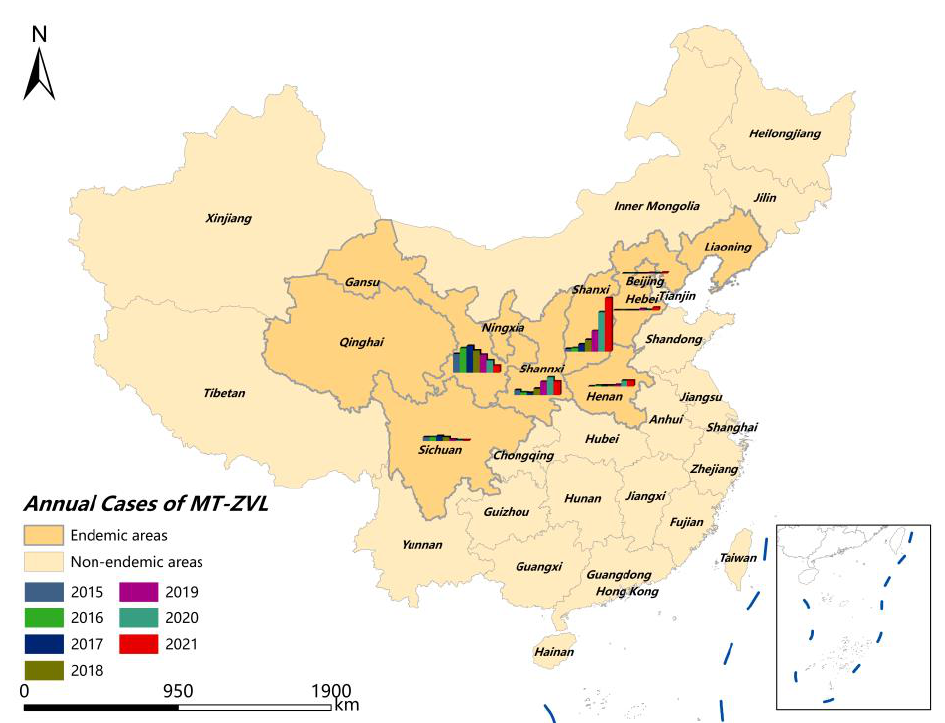
Figure 2. Geographical distribution of patients with mountain-type zoonotic visceral leishmaniasis in China from 2015 to 2021.